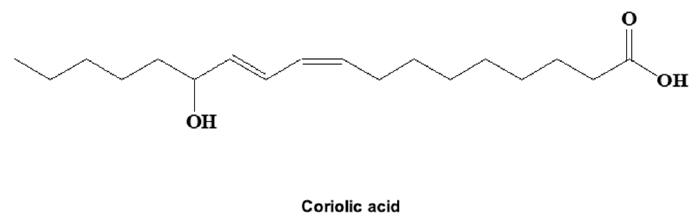
Figure 2. Molecular structure of coriolic acid, the cancer stem cell (CSC) inhibitor isolated from S. herbacea